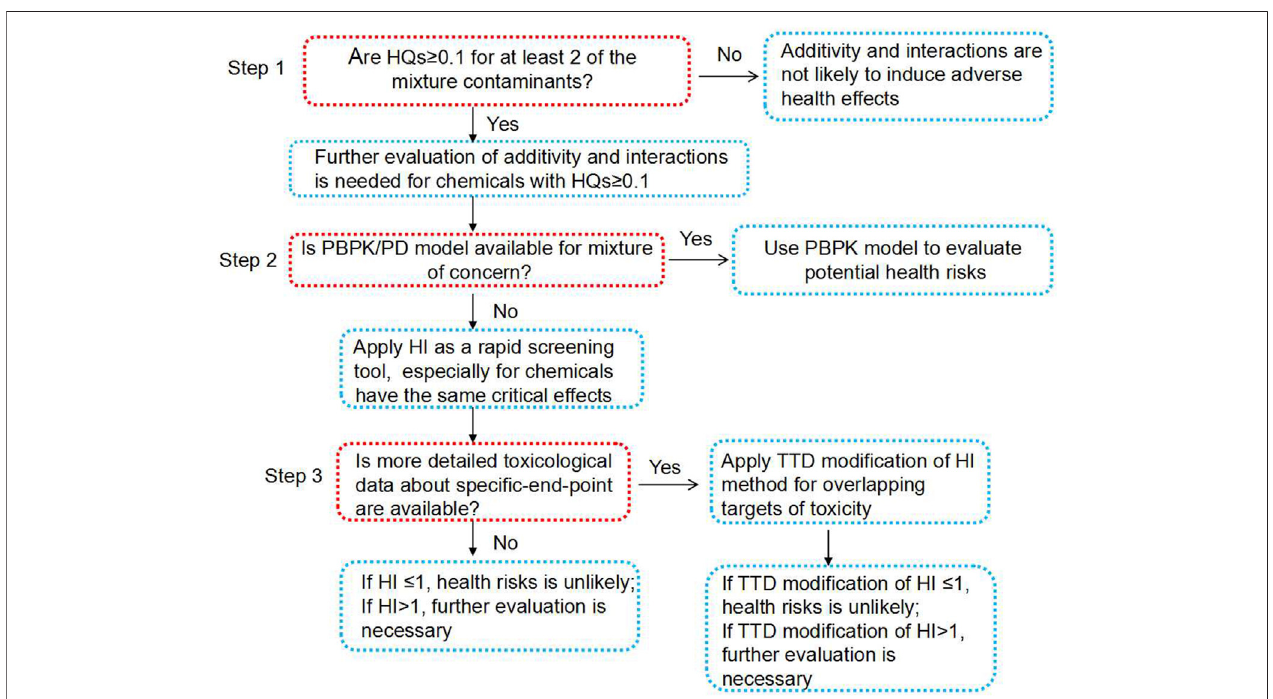
FIGURE 4 | The decision tree for cumulative risk assessment of heavy metals in food homologous TCM.